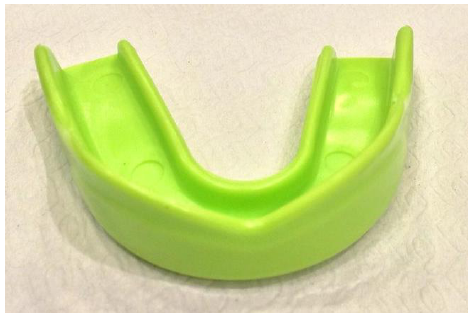
Figure 1. Commercially available mouthguard on the